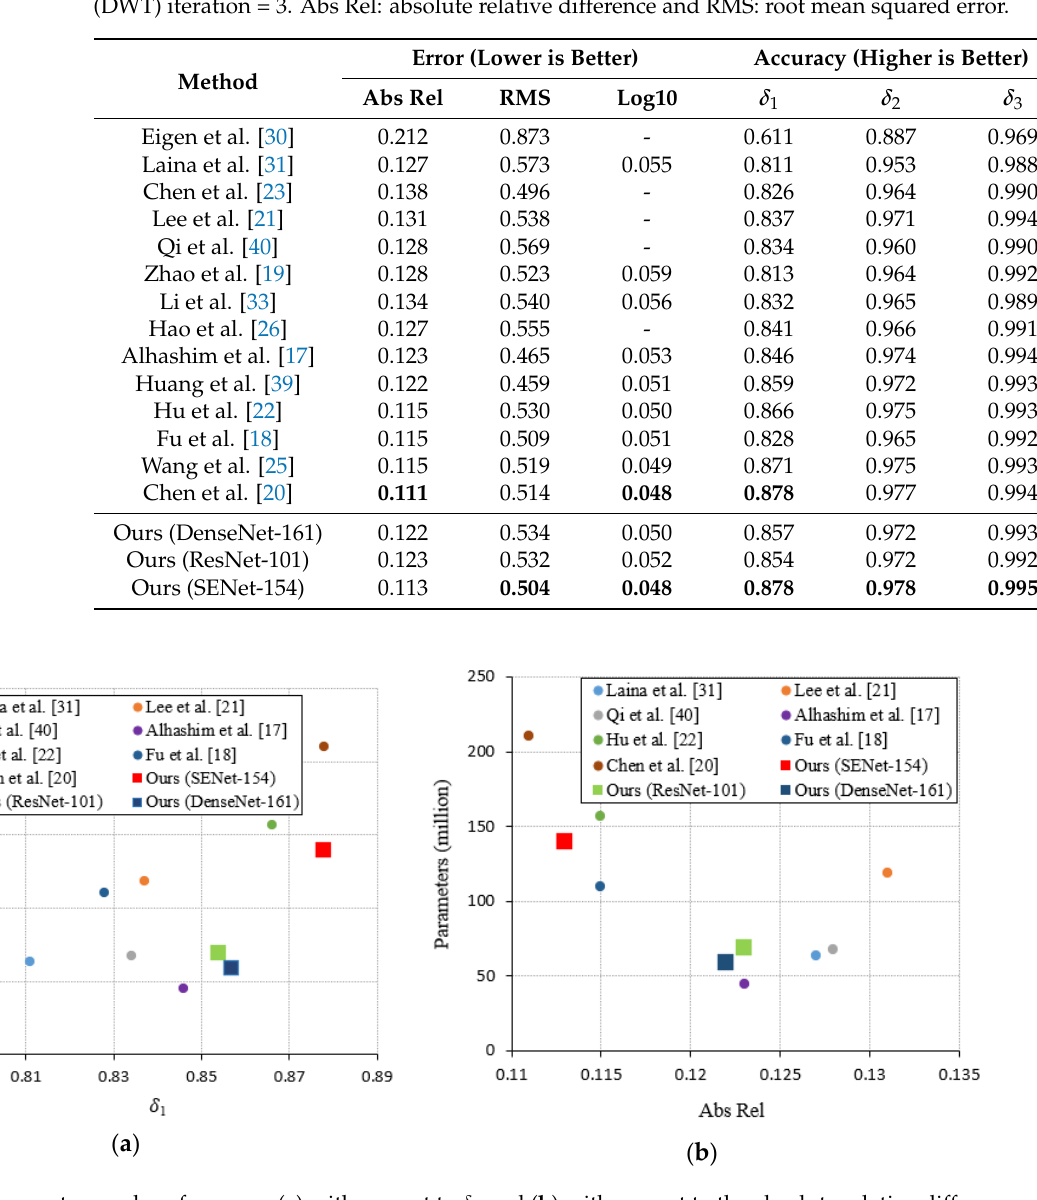
Figure 7. Qualitative evaluations on NYU-Depth-V2. Rows from top to bottom: original RGB images, ground truth depth maps, Laina et al. [31], Alhashim et al. [17], Hu et al. [22], Chen et al. [20], and the proposed method. Regions in black boxes highlight the better-predicted results. Color indicates depth, where red is far and blue is close. Table 2 compares the proposed method on the KITTI test dataset using the SE- Net-154 encoder, with some quantitative comparisons in Figure 8 and more qualitative